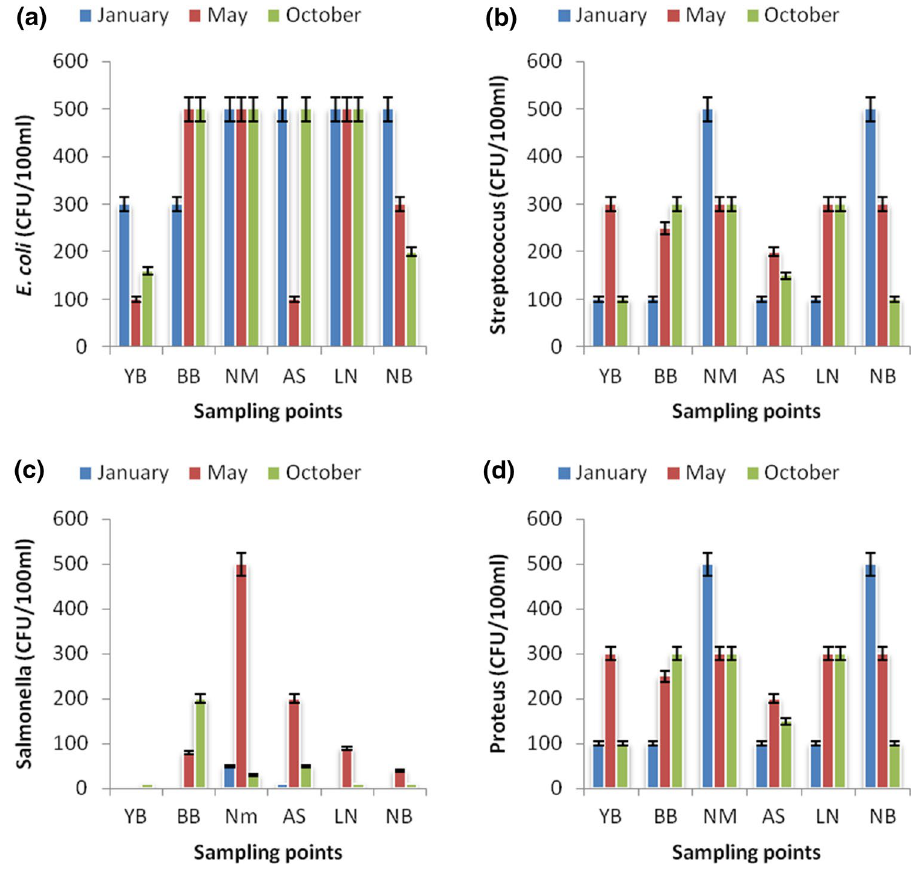
Fig. 8 Seasonal variations in a E. coli ; b